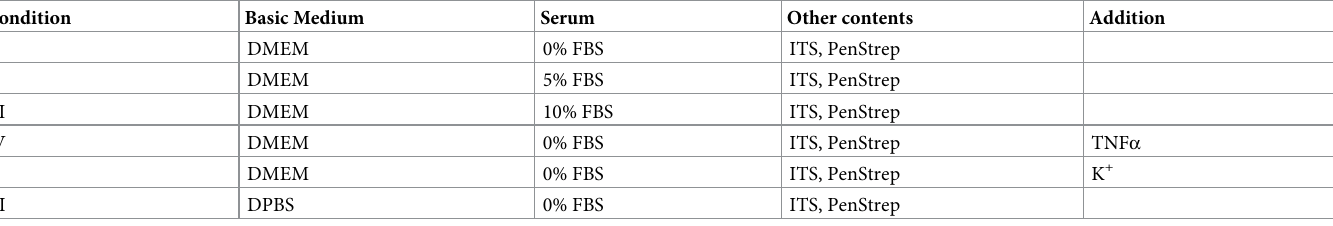
Table 2. Culture